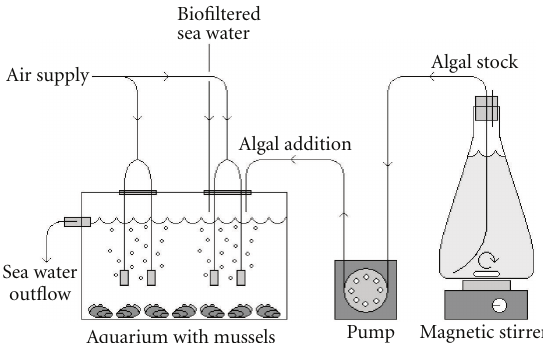
Figure 2: Conceptual illustration of experimental approach for using the steady-state method (Figure 1) to identify the upper algal concentration above which Mytilus edulis reduces its filtration rate. At algal concentrations above the lower threshold ( C l ), M. edulis is stimulated to open its shells and exploit its filtration rate capacity so that a steady state is maintained over an extended period of time, but, when the algal concentration is elevated above an upper concentration threshold ( C u ), the mussel becomes saturated ( s ) after some time ( Δ t ) so that the mussel shuts down thus giving rise to a rapidly increasing algal concentration in the